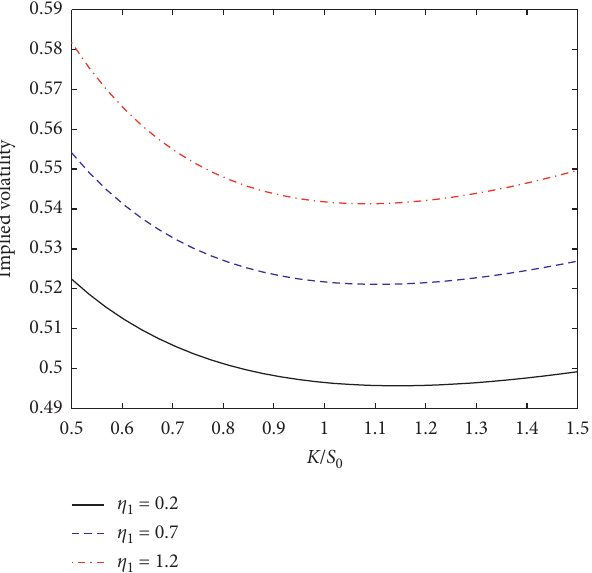
Figure 3: Implied volatility for different values of η